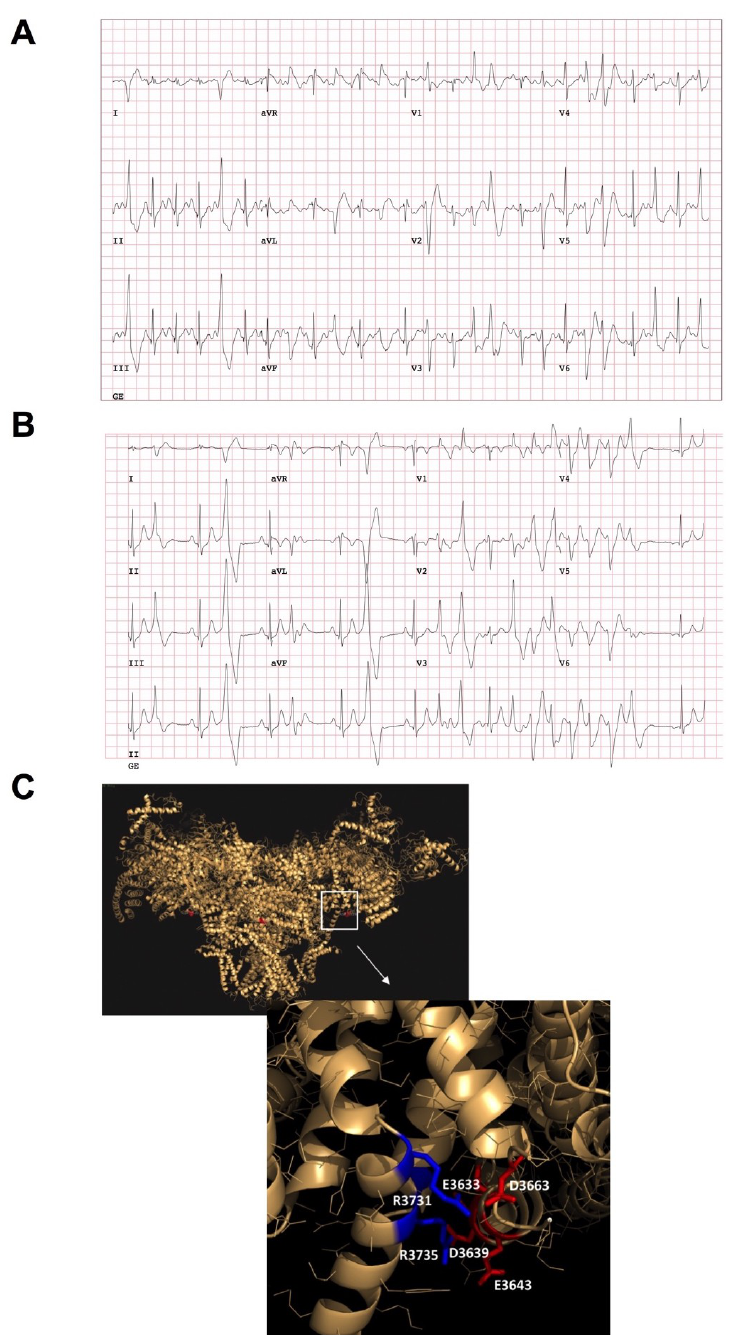
Figure 1. Clinical characterization of the catecholaminergic polymorphic ventricular tachycardia (CPVT) patient and in silico modeling. ( A ) An exercise treadmill test showed a normal QT response to exercise and in recovery, singlet premature ventricular contractions (PVCs) and occasional couplets occurred with exercise with multifocal non-short-coupled PVCs (predominantly RBBB, inferior axis). ( B ) An exercise treadmill test when the proband was treated with metoprolol (METO) (predominantly RBBB, Inferior axis). ( C ) RyR2-D3638A mutation location (red dot, D3639A on the pig amino-acid sequence) on the pig 3D ryanodine receptor (RyR2) resolved structure [4] using MacPyMOL (version 1.7.4.5) and the available PDB file 5goa.cif. This mutation is located in the RyR2 central core domain. In silico modeling analysis revealed that the RyR2-D3638A mutation is located on the surface of a contact between two alpha-helices, via positively charged side chain clusters (K3698, R3731 and R3735) on one side and negatively charged side chains (E3633, E3638, D3639, D3663) on the other side.